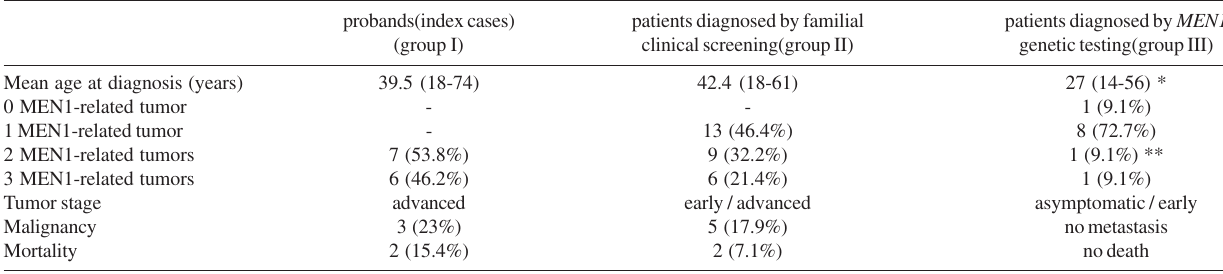
Table 3 - Clinical manifestations of MEN1 in patients with MEN1: index cases (group I), clinically diagnosed cases (group II), and genetically diagnosed cases (group